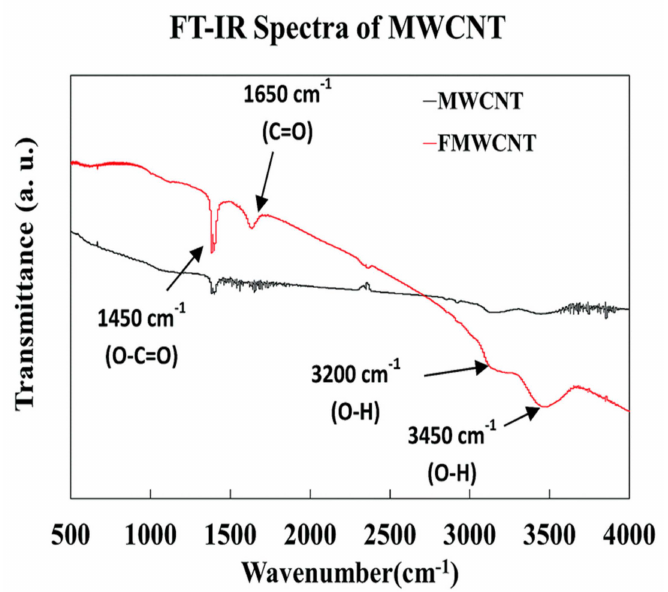
Figure 1. The Infrared (IR) spectra of reference and functional MWCNTs showing hydroxyl group (–OH) and carbonyl group (–CO) attached after acid